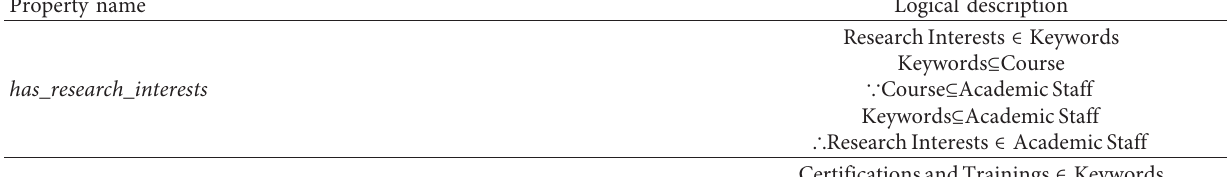
Table 1: The properties used with their logical description.